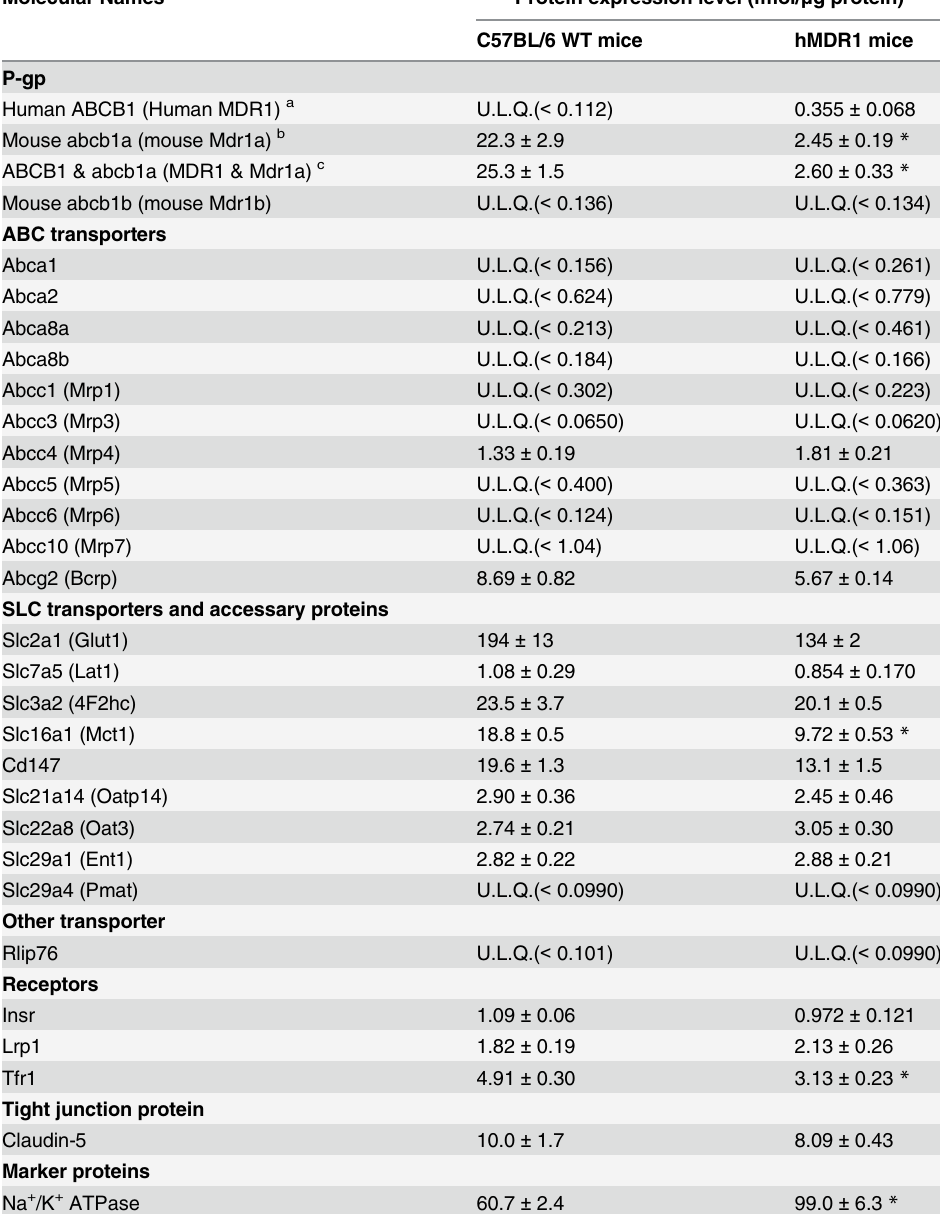
Table 5. Protein expression levels of membrane proteins in brain capillaries isolated from C57BL/6 WT and hMDR1